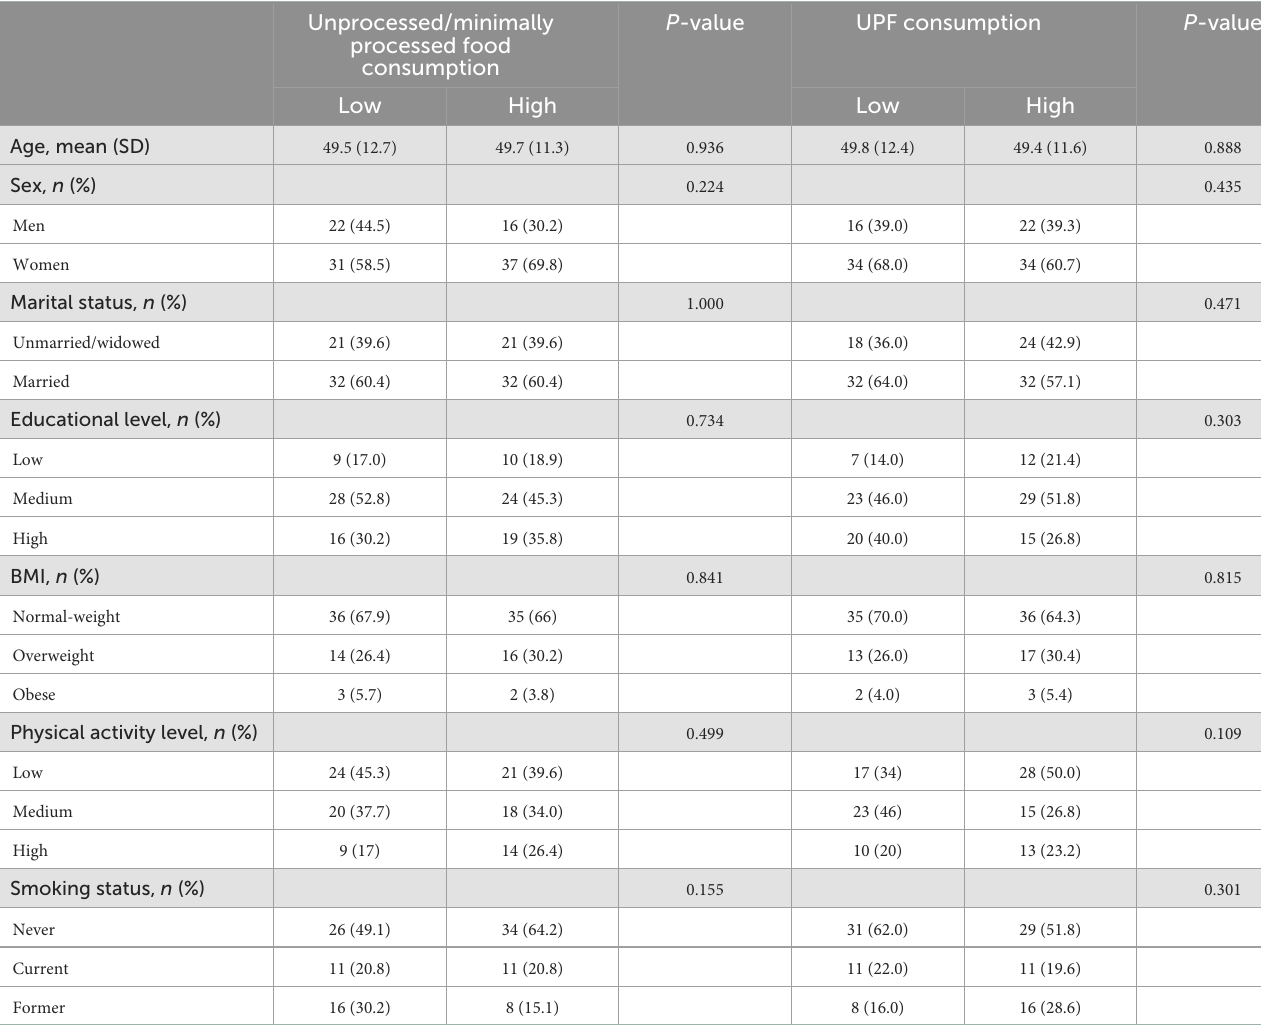
TABLE 1 Baseline characteristics of the study sample according to consumption of foods by level of processing according to NOVA classification in the study sample ( n = 106). Unprocessed/minimally processed food